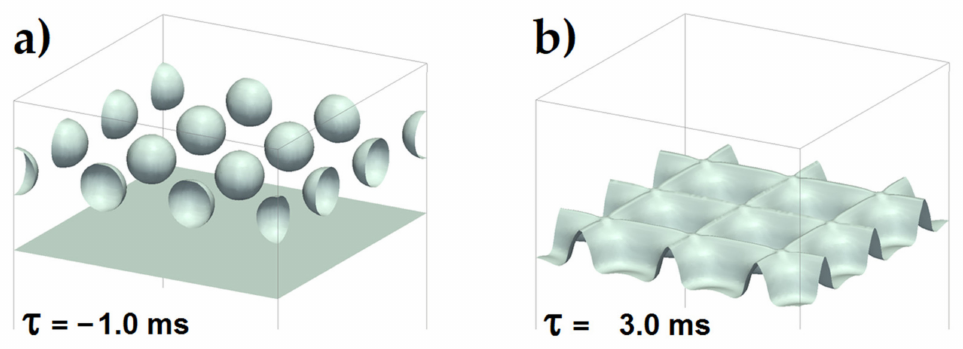
Figure 14. Three-dimensional view of the initial drop positions ( a ) 1 ms before the impact, and of the free surface configuration ( b ) 3 ms after the impact for a case with 16 drops uniformly distributed in the domain, impact velocity 1.4